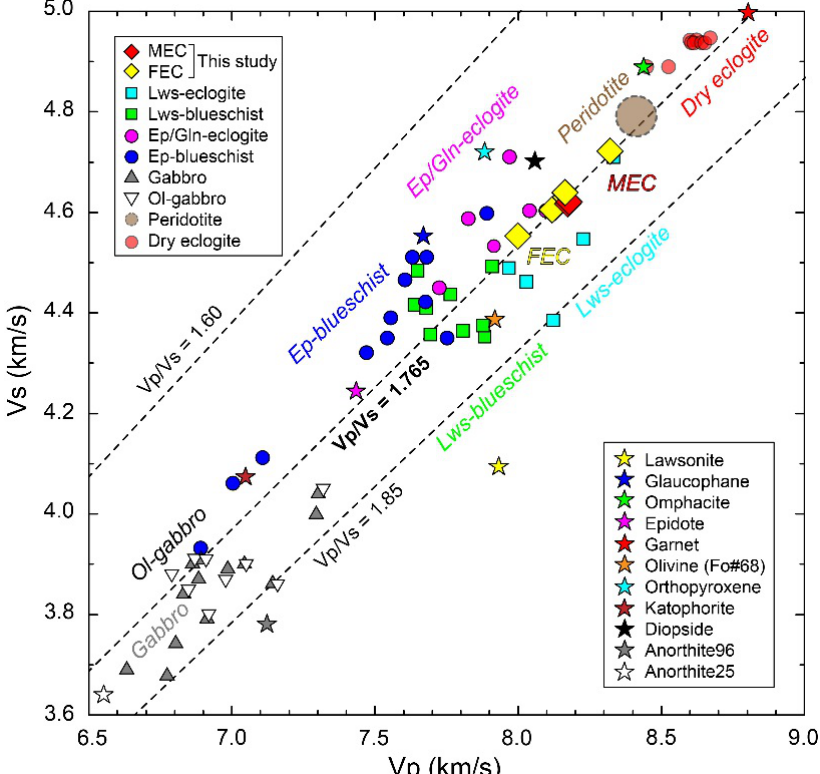
Figure 13. Seismic velocities (Vp and Vs) of the Flem eclogite (MEC and FEC) and other rock types in ambient conditions. The star symbols denote the seismic velocities of isotropic mono-mineralic polycrystals. Data source:s lawsonite eclogite [13], lawsonite blueschsit [13,69,70], epidote/glaucophane eclogite [14,73,74], epidote blueschsit [14,70,73,74], dry eclogite [22], peridotite [81], (olivine) gabbro [82].